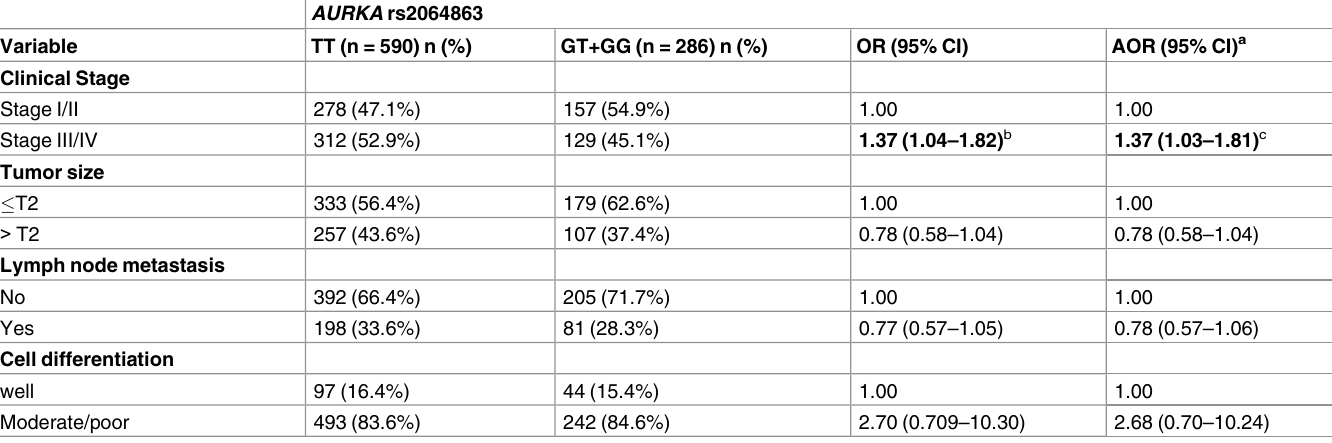
Table 4. Effect of AURKA rs2064863 polymorphism on clinical statusesin 786 male oral cancer. AURKA